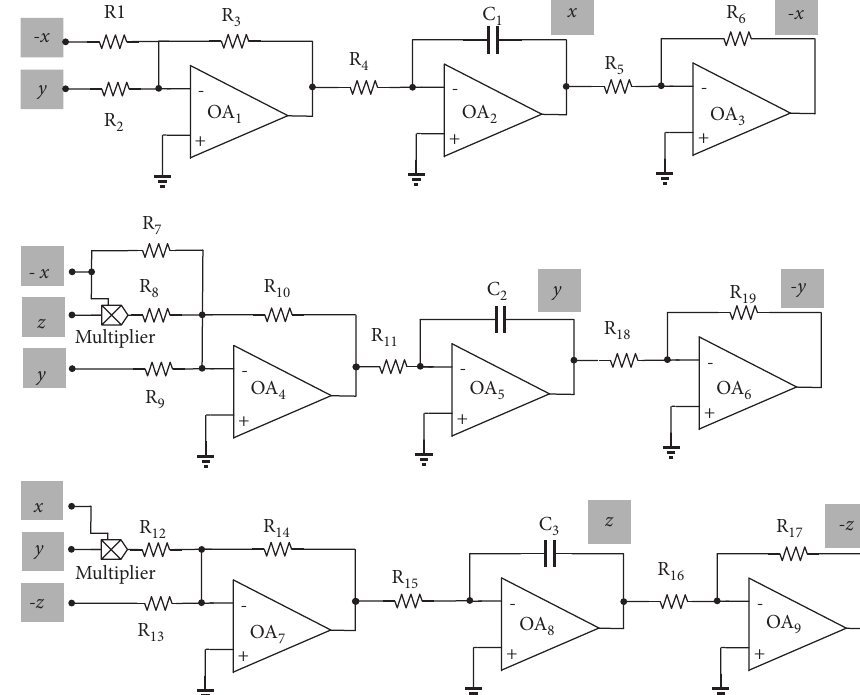
Figure 2: The fully integrated Chen chaotic oscillation circuit.